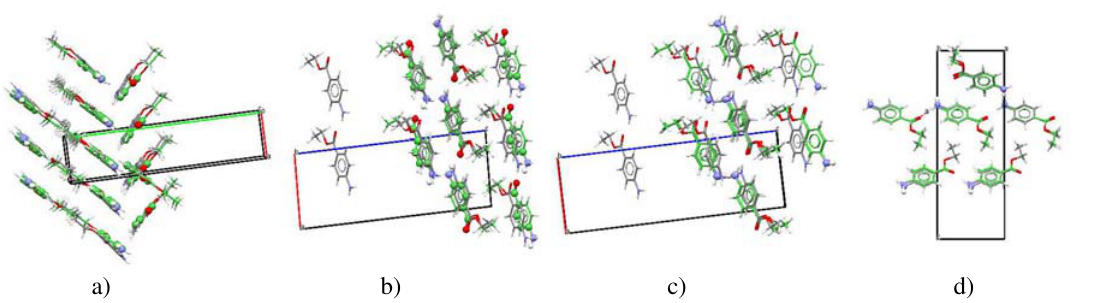
Fig. 3. Crystal packing similarity between a) Str210(blue) and Form II (green) b) Str 302 (blue) and Form I (green) c) Str 362 (blue) and Form I (green) d) Str 158(blue) and Form II (green) with 20 molecules in common in a coordination sphere. [ Str 210, Str 302, Str 362 and Str 158 are theo- retically predicted conformers, Form I and II are experimental known polymorphs. ]